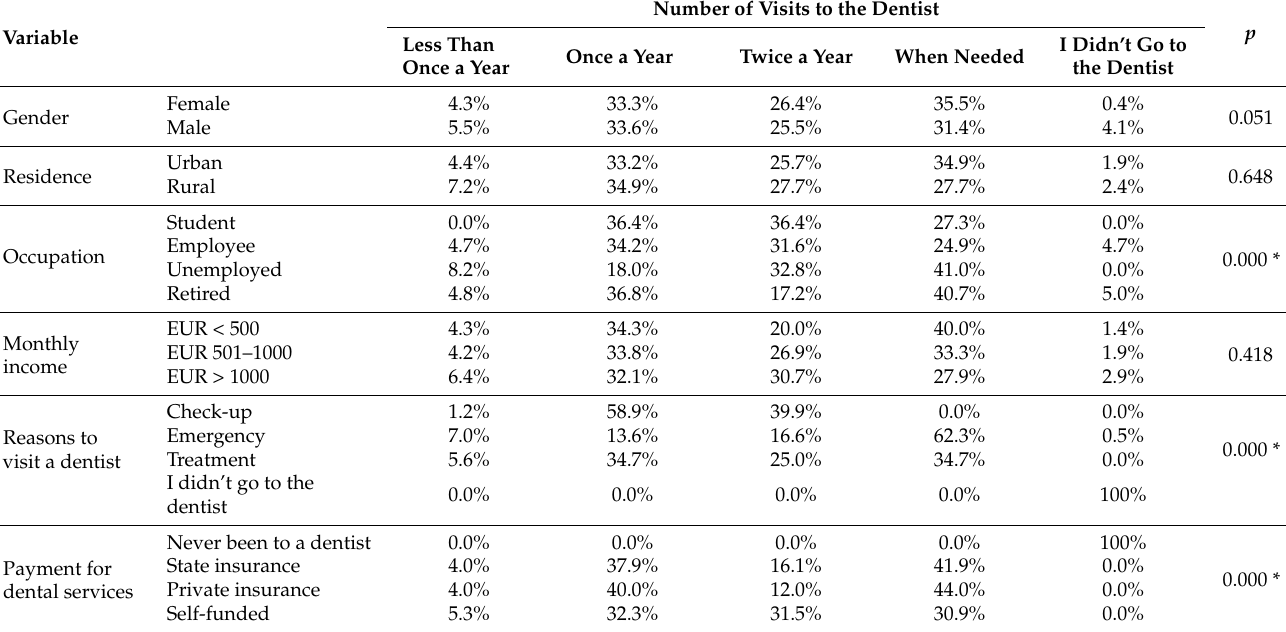
Table 2. Factors related to dental service’s frequency of